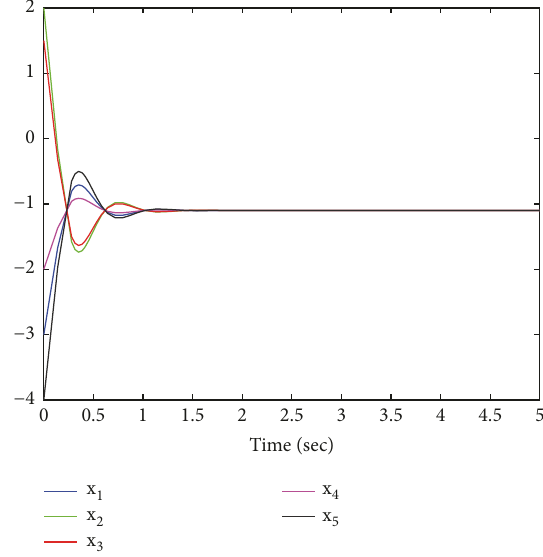
Figure 11: Sates of graph G 𝑜𝑝𝑡 , 𝜏 = 0.14𝑠